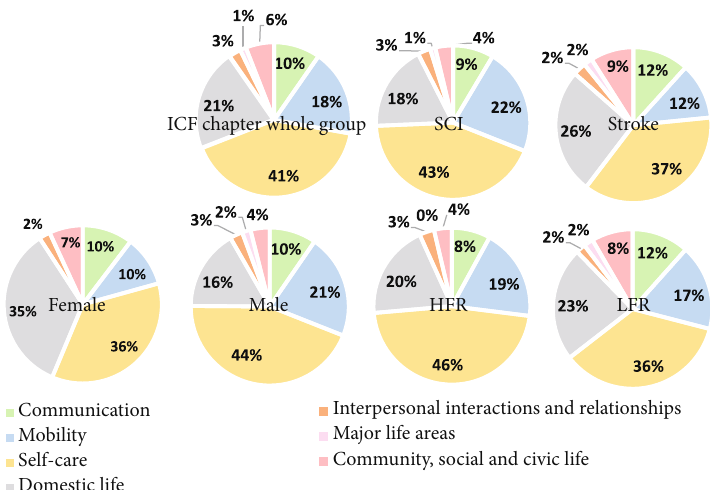
Figure 2: ICF mapping of occupational performance goals identi fi ed by the study population as a whole and split in diagnosis, sex and regimen. SCI = spinal cord injuries; HFR = high-functioning regimen; LFR = low-functioning